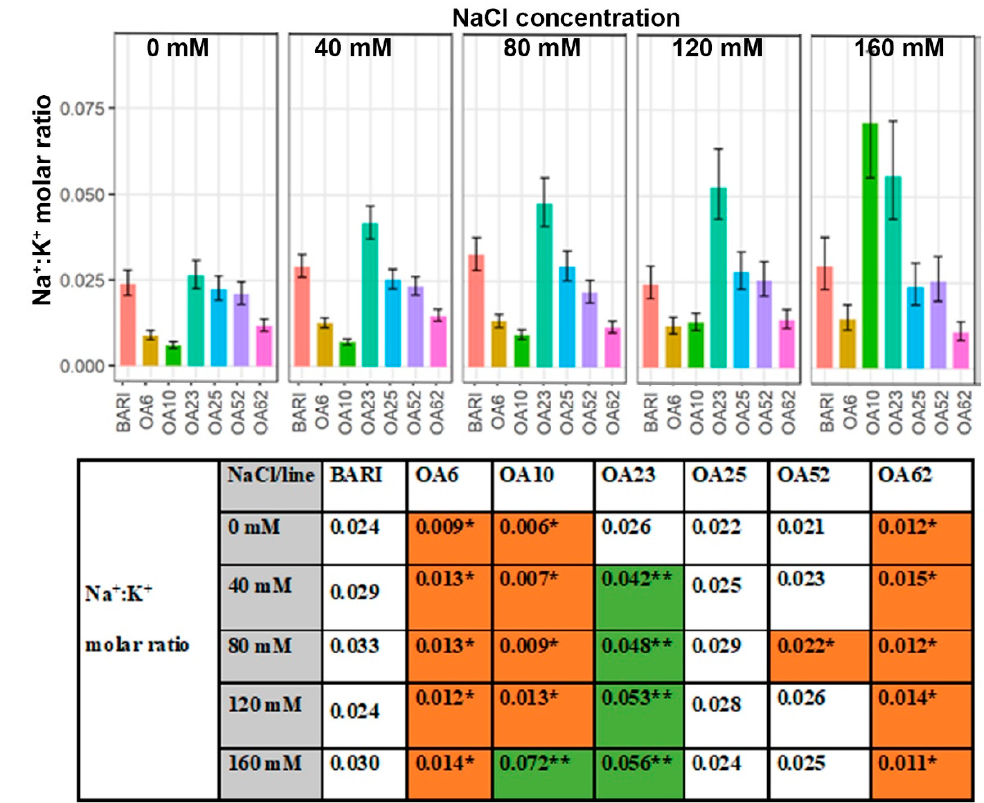
Figure 5. Na + :K + molar ratio at DAP 39–40. Data are shown for the control BARI Gom-25 (BARI) and mutagenized wheat lines OA6, OA10, OA23, OA25, OA52, and OA62 at DAP 39–40. NaCl concentrations applied were in the range from 0 mM to 160 mM. Upper panel: Na + :K + ratio values with half-LSD error bars. Lower panel: table high-lighting the Na + :K + ratio mean values with color codes for significantly higher (dark green **) or lower (orange *) values compared to BARI Gom-25, p ≤ 0.05.